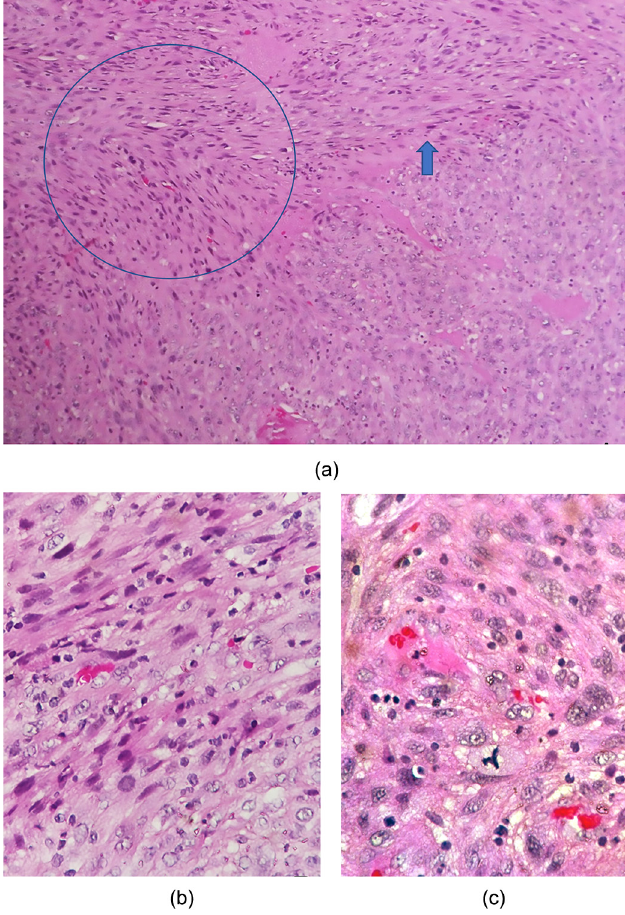
Fig. 1. Case 1. Histopathological examination of haematoxylin-eosin stained specimen. Myo fi broblastic tumour cells showing fascicular pattern (blue arrow) and vague storiform pattern (blue circle) (a); Tumour cells ranges from tapering to ovoid with plump vesicular nuclei, prominent nucleoli and pale cytoplasm (b); Bizarre, atypical cells and aberrant mitosis (c) (a,100 (cid:1) ; b and c, 400 (cid:1) ).